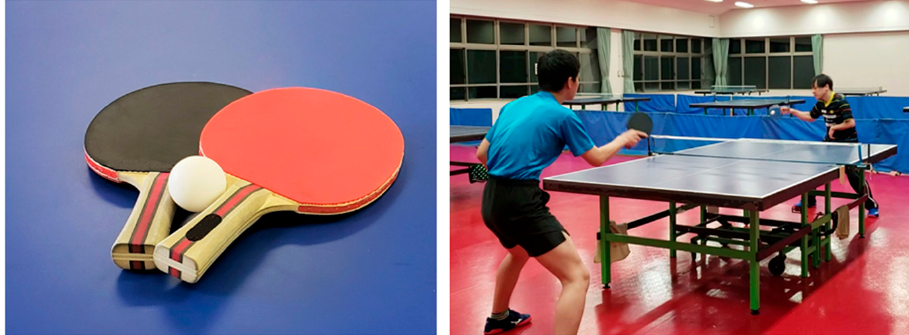
Figure 1. Table tennis rackets and ball ( left ), adapted from photo AC (https://www.photo-ac.com/, accessed on 13 July 2022), and two players engaged in a rally with the ball about to be struck in the far court ( right ).